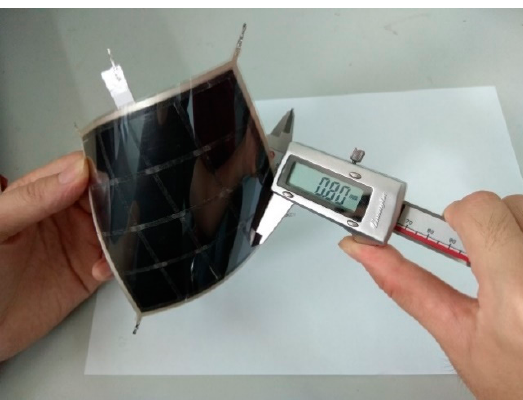
Figure 9. The sensor sample.